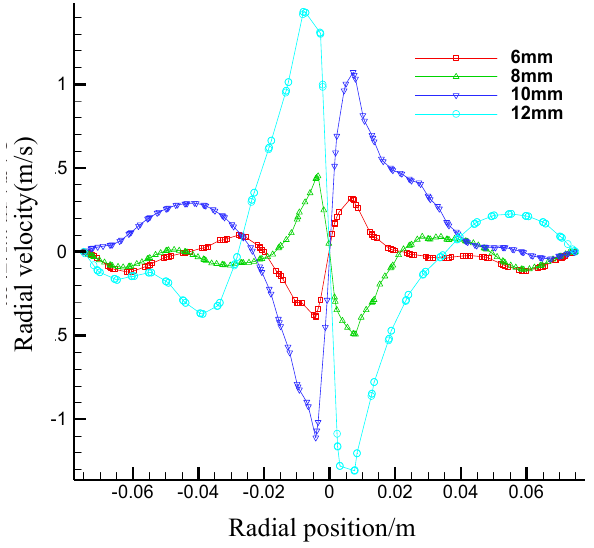
Figure 22. Radial velocity inside cyclone with different II underflow pipe.